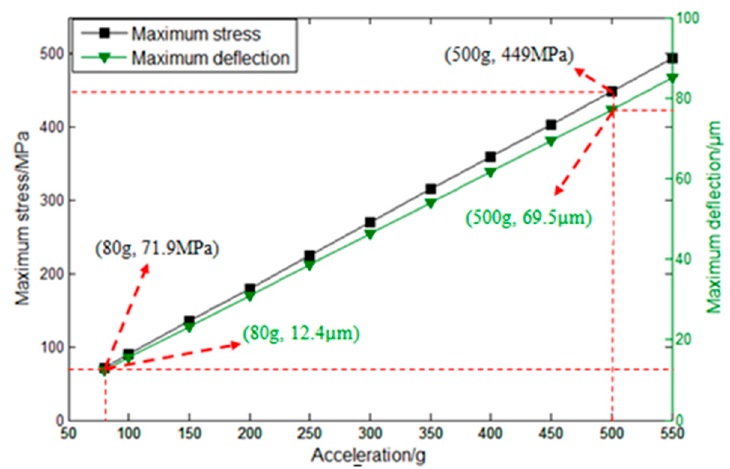
Figure 10. The results of deflection analysis.